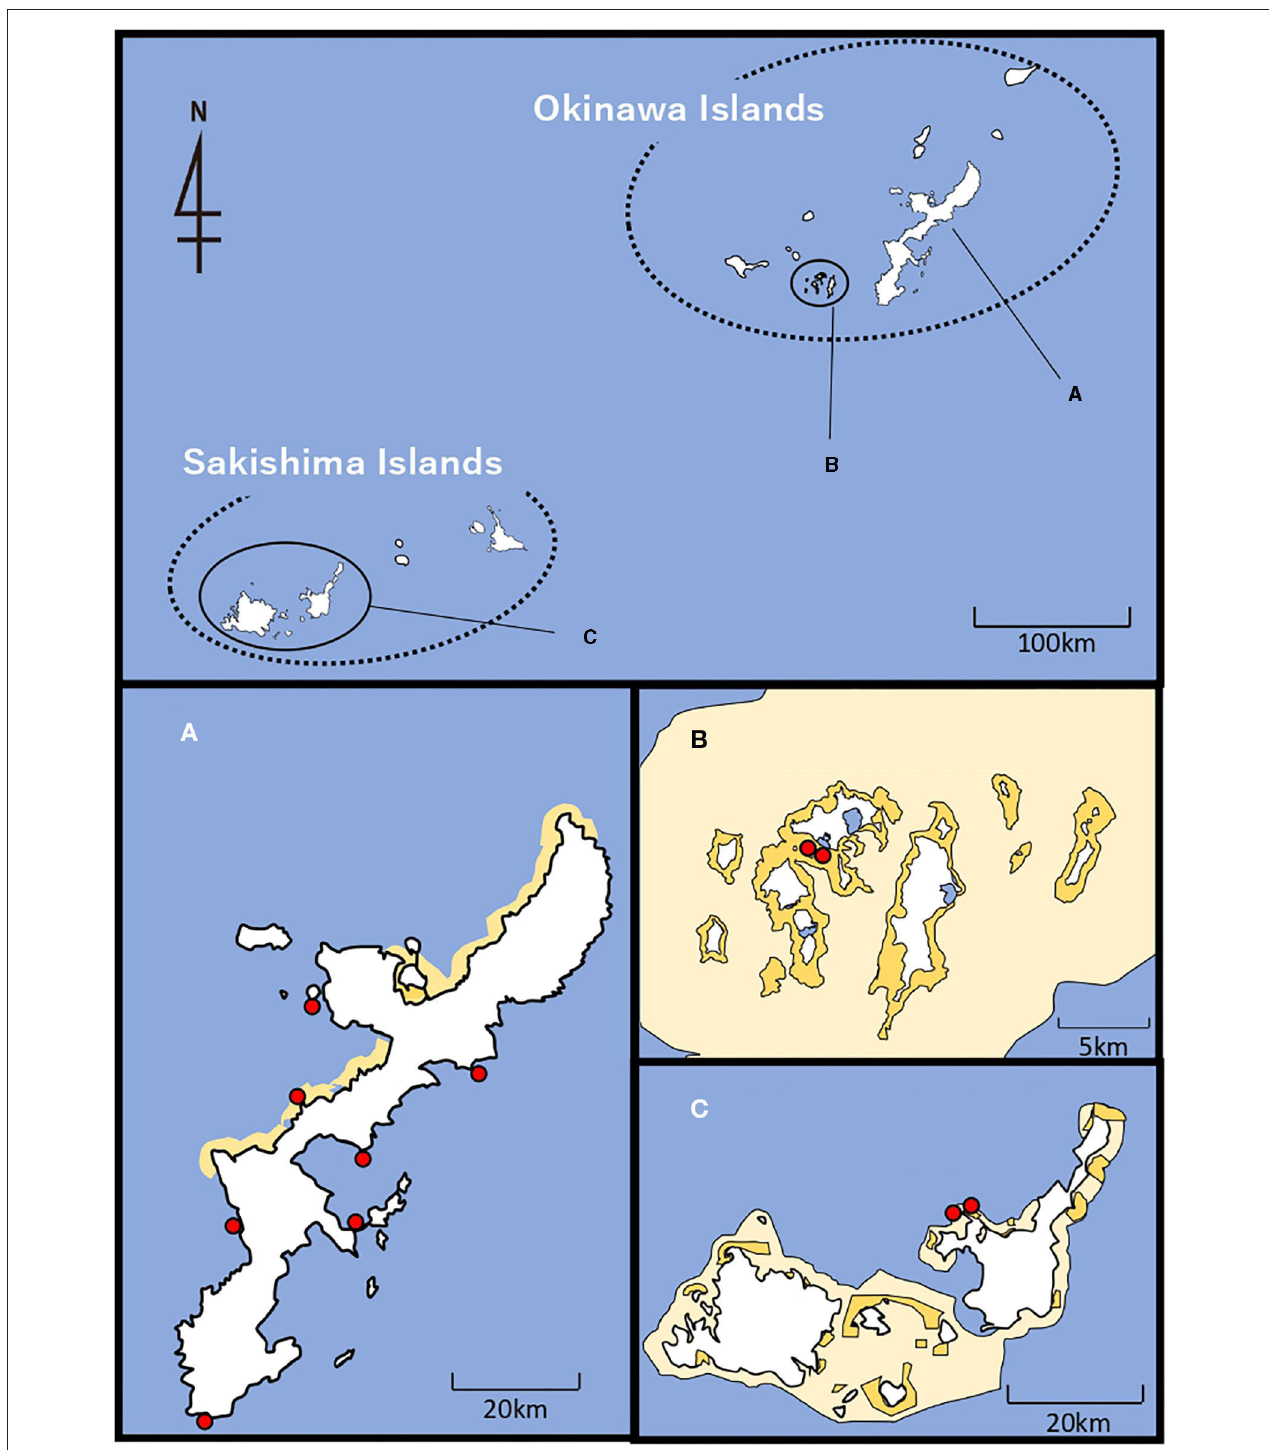
FIGURE 1 | Map of sampling locations of H. atra in central and southern Ryukyu Islands. (A) Okinawajima Island, (B) Kerama Islands including Zamami Island and (C) Sakishima Islands including Ishigaki Island. National and quasi-national parks are shown with light yellow ( = range of parks) and dark yellow ( = marine protected areas). Red dots indicate sampling